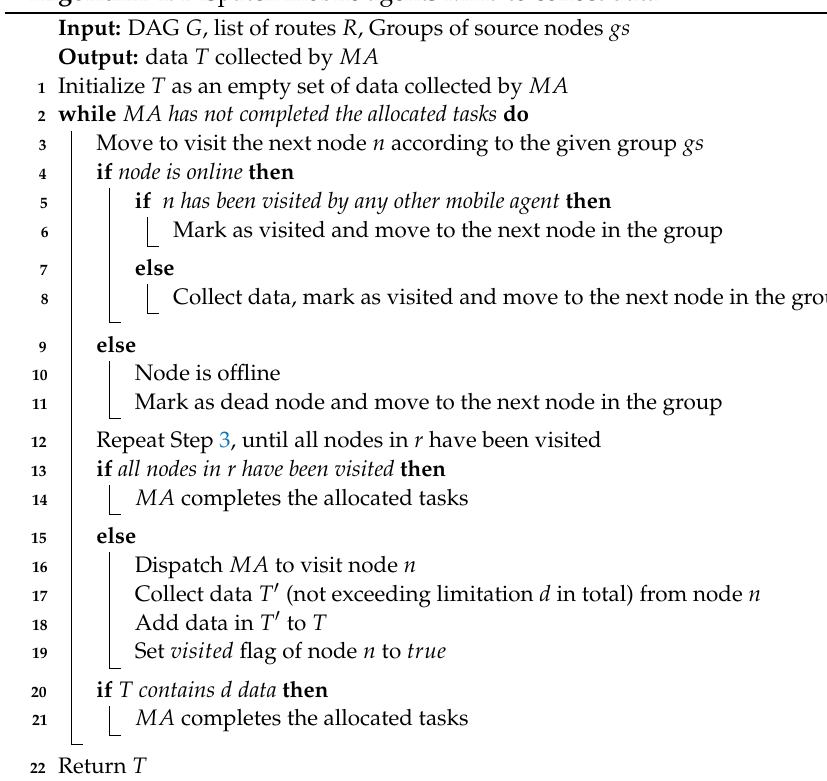
Algorithm 4: Dispatch mobile agents MAs to collect